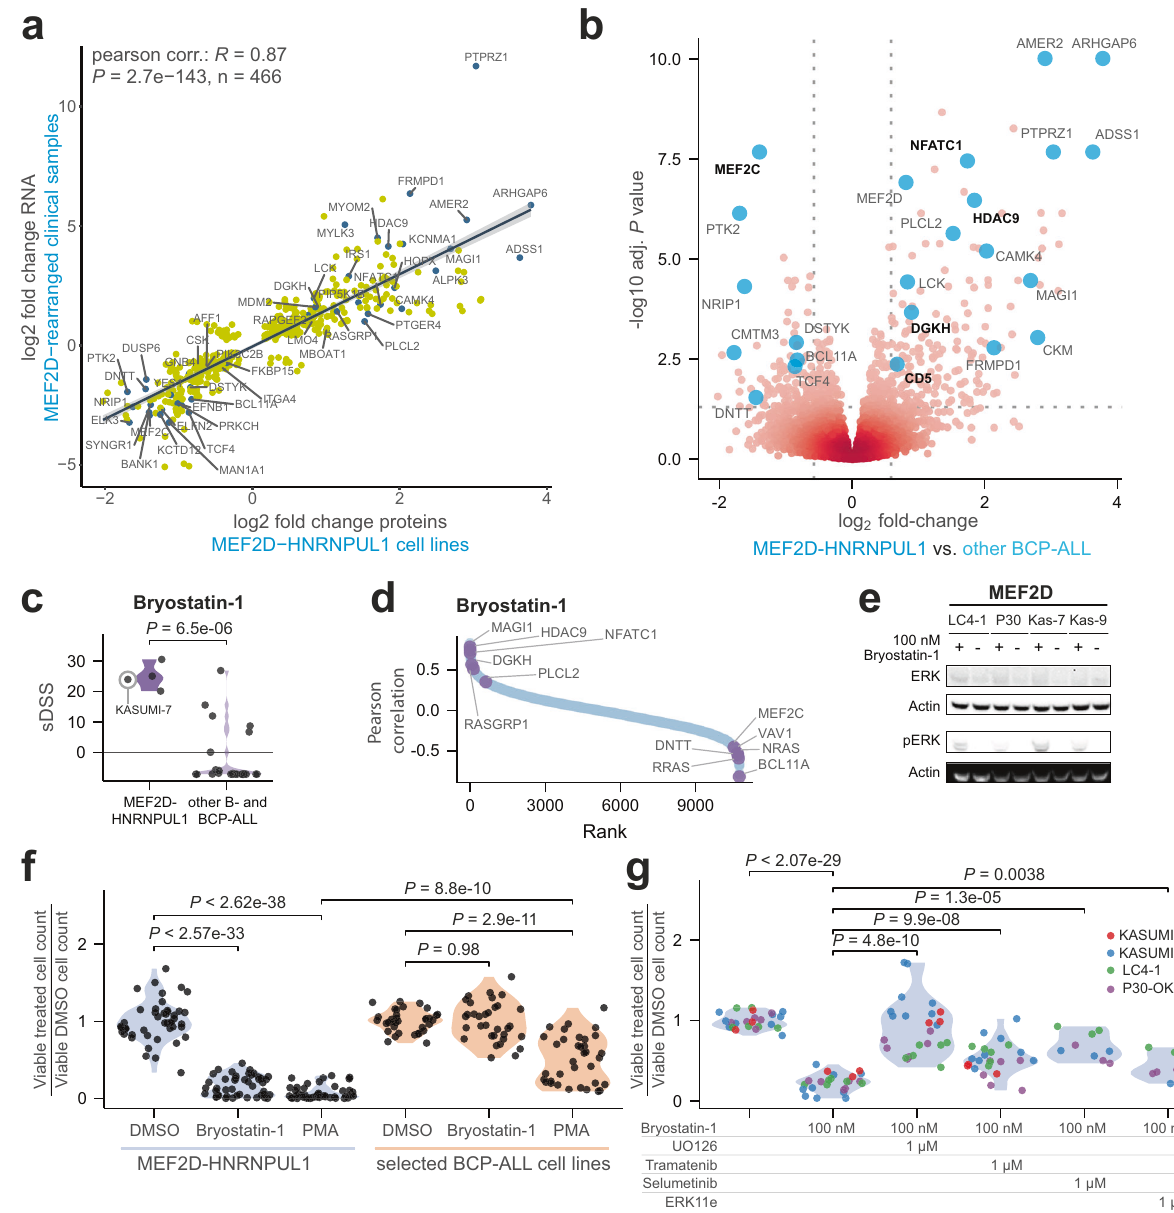
Fig. 6 Selective sensitivity of MEF2D-HNRNPUL1 cell lines to bryostatin-1. a Fold changes of differentially expressed mRNA using edgeR in 20 clinical patient samples with different MEF2D -rearrangements ( MEF2D-BCL9 n = 13, MEF2D-HNRNPUL1 n = 4, MEF2D-CSF1R n = 1, MEF2D-SS18 n = 1, and MEF2D- DAZAP1 n = 1) plotted against differentially abundant proteins in the MEF2D-HNRNPUL1 cell lines ( n = 3) using DEqMS. Only differentially expressed mRNA that passed a P value ≤ 0.01 (two-sided t -test) are shown in the scatter plot with selected highlighted genes. N indicates the number of genes passing this criterion. R Pearson correlation coef fi cient. P two-sided t-distribution P value. b Volcano plot of the differential protein levels in the MEF2D-HNRNPUL1 cell lines and their replicates ( n = 6) versus the rest of the BCP-ALL cell lines and replicates ( n = 37) using DEqMS (spectra counts adjusted t -test). The cut-off was set at P ≤ 0.05 and the fold change was set to log2(1.5). Selected proteins are highlighted with blue circles. c The sDSS of bryostatin-1 in the MEF2D- HNRNPUL1 cell lines ( n = 4) compared to the sDSS for the remaining BCP-ALL cell lines ( n = 24). The two-sided t -test P value is indicated as ( P ). d Ranked bryostatin-1 sDSS and protein level Pearson correlations with selected highlighted proteins in purple. e Western blot of ERK1/2 and pERK1/2 (Thr202 and Tyr204) of MEF2D-HNRNPUL1 fusion cell lines LC4-1, P30-OHKUBO (P30), KASUMI-7 (Kas-7), and KASUMI-9 (Kas-9) after 2 h treatment with 100 nM bryostatin-1. f Viable cell quanti fi cation normalized to corresponding mean DMSO viable cell count of the four MEF2D-HNRNPUL1 fusion cell lines, treated with 100 nM of bryostatin-1 or 25 nM PMA. An equal volume of DMSO was used as a control ( n = 3). BCP-ALL cell lines ALL-PO, REH, RCH-ACV, NALM- 6, SUP-B15, COG-LL-355h, COG-LL-394h, and MHH-CALL-2, lacking the MEF2D-HNRNPUL1 fusion, were subjected to the same treatments. Viable cells were quanti fi ed by fl ow cytometry, excluding zombie aqua dyed non-viable cells. Results are merged from fi ve independent experiments. P values were obtained from unpaired two-sided t -tests. g Viable cell quanti fi cation normalized to corresponding mean DMSO viable cell count of the four MEF2D- HNRNPUL1 fusion cell lines, treated with 100 nM of bryostatin-1 alone or in combination with 1 uM MEK inhibitors UO126, trametinib, or selumetinib. Alternatively, to block ERK directly, 1 uM ERK inhibitor ERK 11e was used, and equal volume of DMSO was used as a control ( n = 3). Viable cells were quanti fi ed by fl ow cytometry, excluding zombie aqua dyed non-viable cells. Results are merged from three independent experiments. P values were obtained from unpaired two-sided t -tests. Source data are provided as a Source Data File